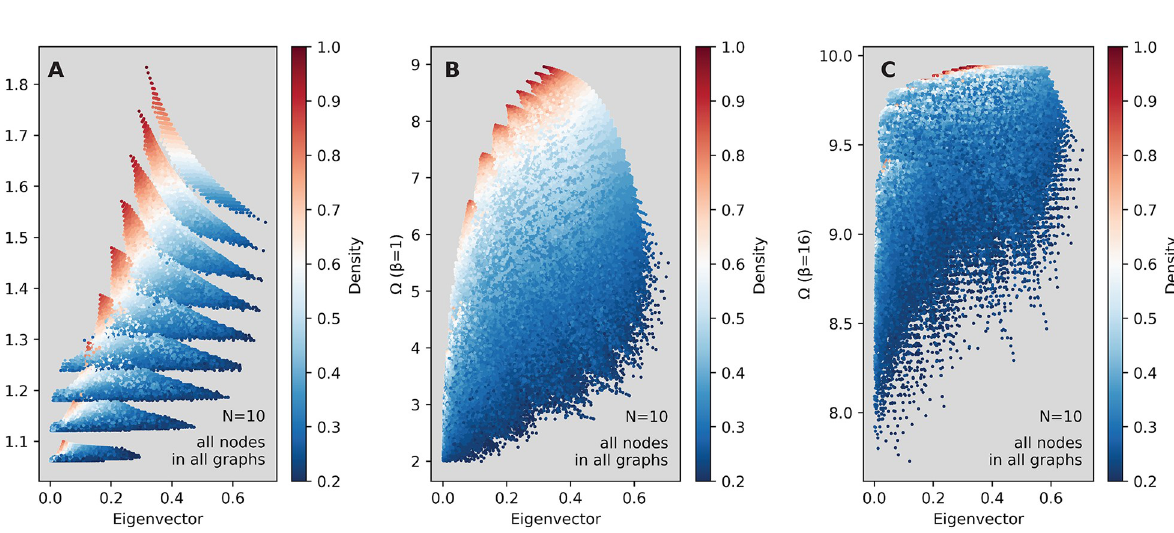
Fig 5. How the expected outbreak size O varies with a centrality measure and the edge density across all small graphs. As Fig 4, except that the color here denotes the network density.